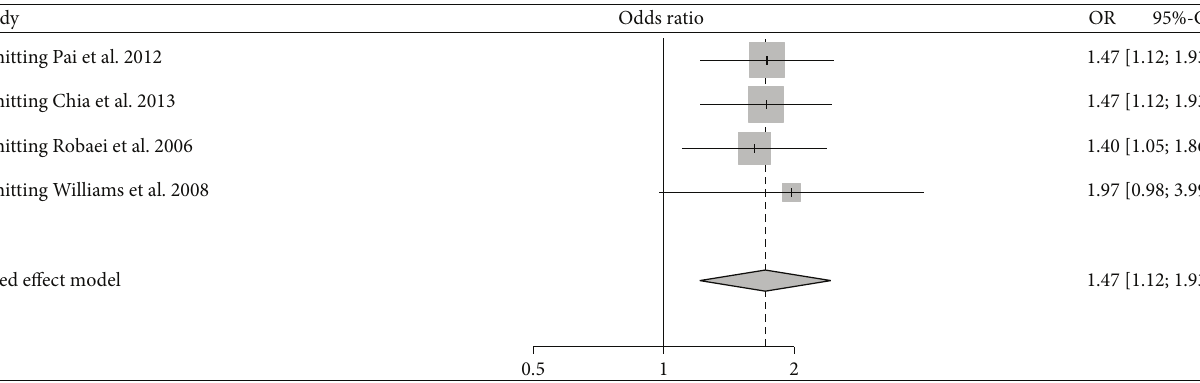
Figure 5: Sensitivity analyses for the influence of each study involving amblyopia on the overall